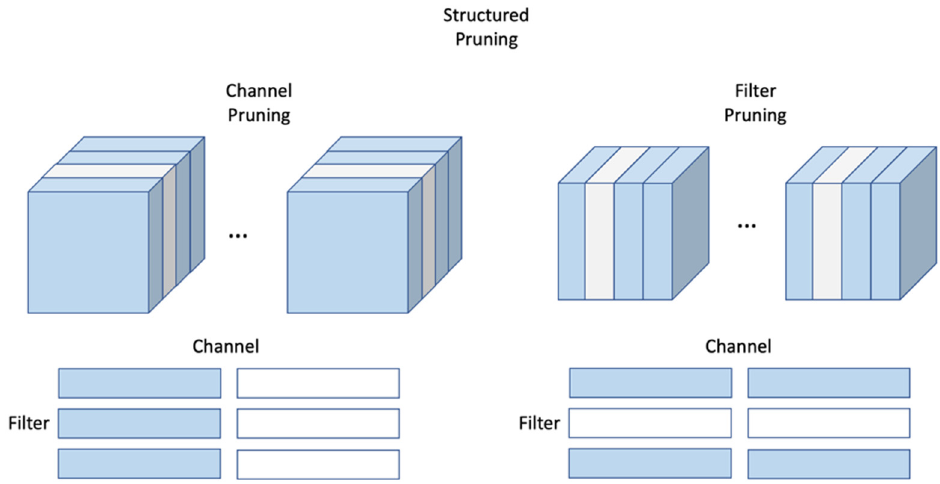
Figure 2. Example of structured pruning.